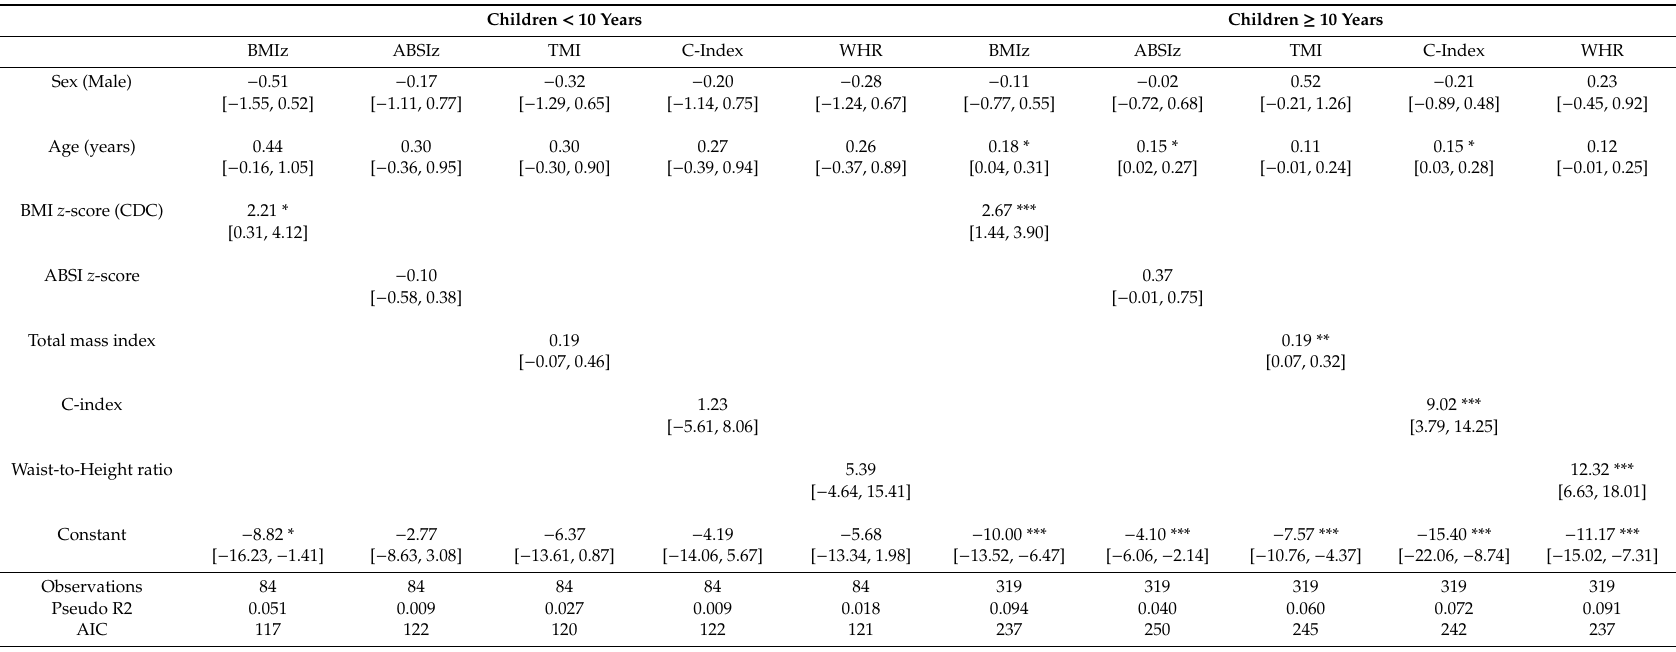
Table 3. Association of anthropometric indexes with the risk of metabolic syndrome according to the age